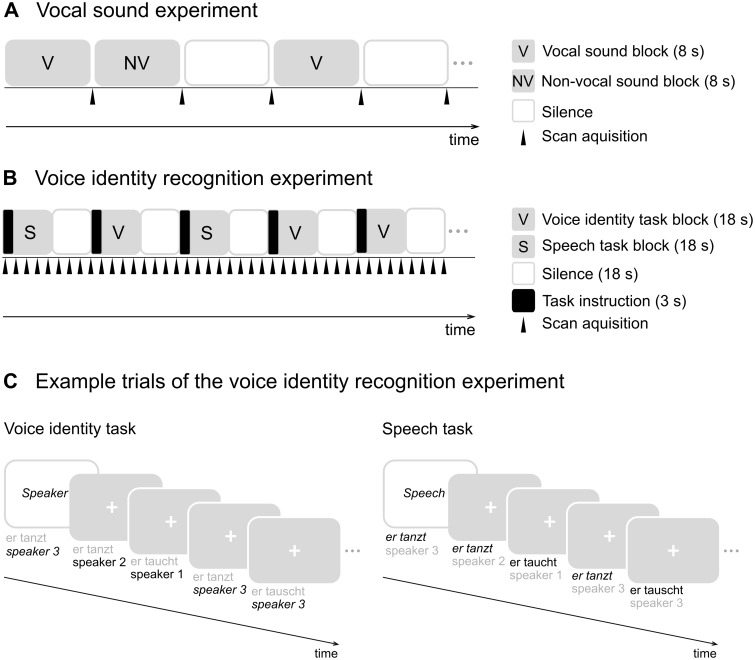
 Experimental design of the two fMRI experiments. (A) In the vocal sound experiment, participants listened to blocks of vocal sounds (V), non-vocal sounds (NV), and silence (white boxes). One brain volume was acquired after each block. (B) In the voice identity recognition experiment, there were two conditions. In one condition, participants had to recognise who was speaking (voice identity task). In the other condition, participants had to recognise what was said (speech task). Stimuli consisted of blocks of 13 auditory sentences. At the beginning of each block, a key-word (‘Speaker’, ‘Speech’) on the screen instructed the participants to perform the voice identity or the speech task. Scans were acquired continuously. (C) Example trials of the voice identity recognition experiment: Participants decided for each sentence whether it was spoken by the target speaker (voice identity task) or whether it matched the content of the target sentence (speech task). Stimuli in the voice identity and speech task blocks were the same.